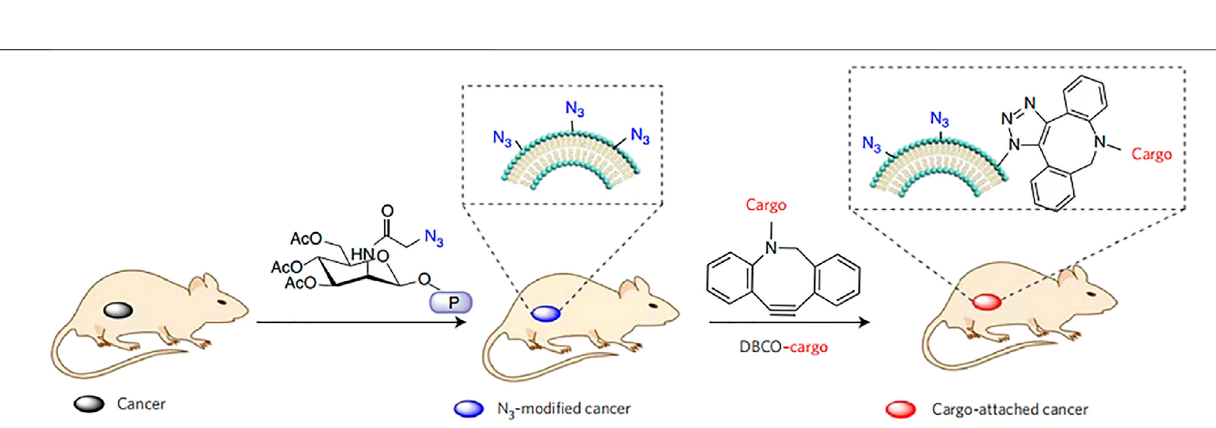
Frontiers in Bioengineering and Biotechnology |